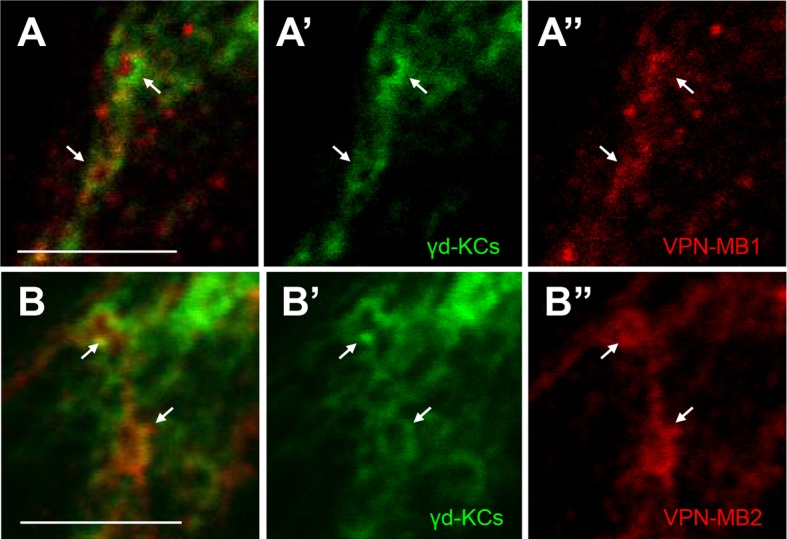
VPNs connect to the γd vAC.(A–A”) Double labeling of VPN-MB1 (MB425B-GAL4, red) and KCs (R13F02-LexA for labeling most KCs, green) reveals overlap in the vAC (arrows). (B–B”) Double labeling of VPN-MB2 (MB334C-GAL4, red) and KCs (R13F02-LexA, green) reveals overlap in the vAC (arrows). Scale bar: 5 µm.